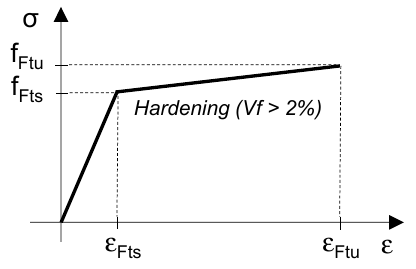
Figure 15. Constitutive law for FRC in tension (adapted from [38]).